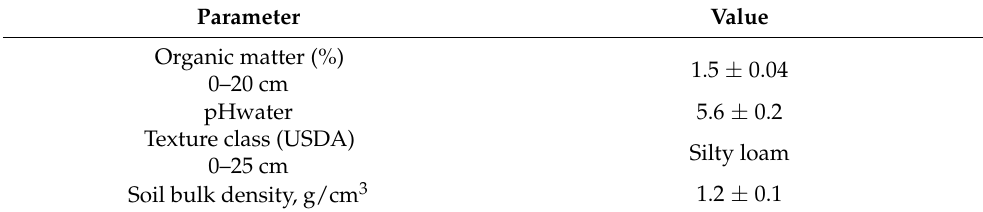
Table 2. Main soil